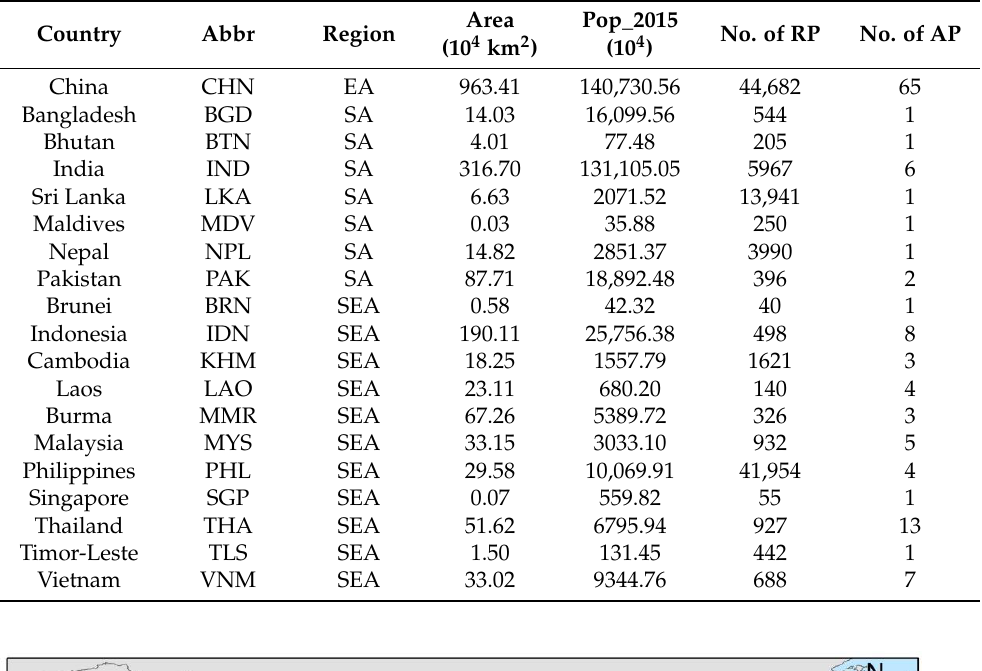
Table 1. The name abbreviation (Abbr), area, 2015 population (Pop_2015), number of residential points (No. of RP), and number of selected airports (No. of AP) for China (EA, East Asia), 8 countries in South Asia (SA) and 10 countries in Southeast Asia (SEA).